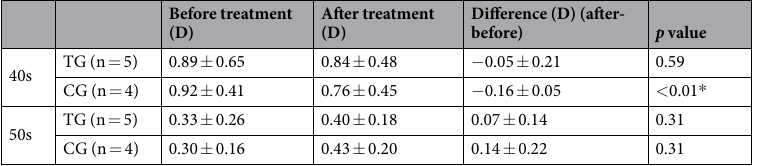
Table 2. Changes in the objective accommodative amplitude by age bracket. The data are expressed as the mean ± standard deviation. 40s = fifth decade of life; 50s = sixth decade of life. * Significant correlation ( p < 0.05 with the Bonferroni correction).